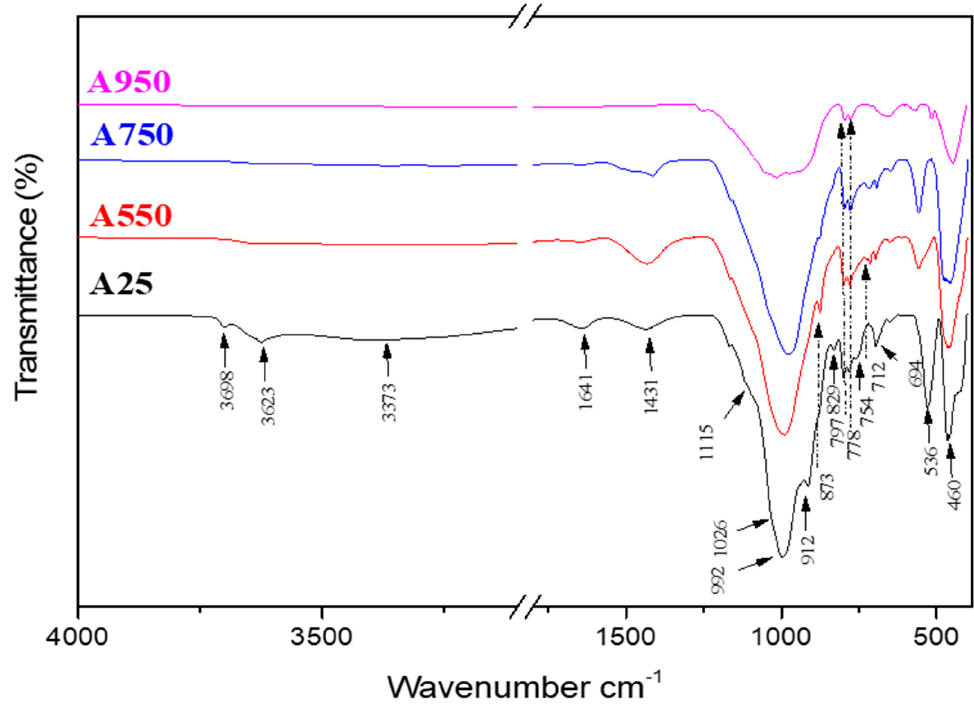
Figure 7. Infrared spectra of A25 A550, A750, and A950 samples .